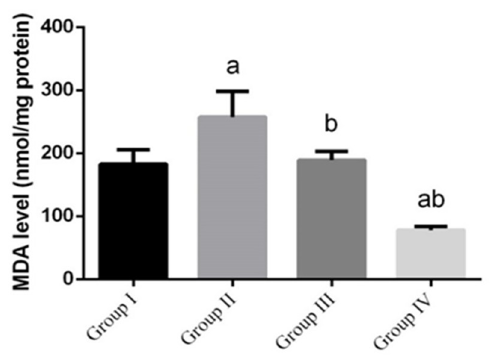
Figure 3. The effect of green Ag-NPs with G. mangostana on intestinal lipid peroxidation, (malondialdehyde, MDA) induced by L. monocytogenes (10 10 CFU/day). Values are means ± SEM (n = 7). ᵃ p < 0.05, significant change compared to control (noninfected negative control) group (G I) and ᵇ p < 0.05, significant change compared to infected group (G II).